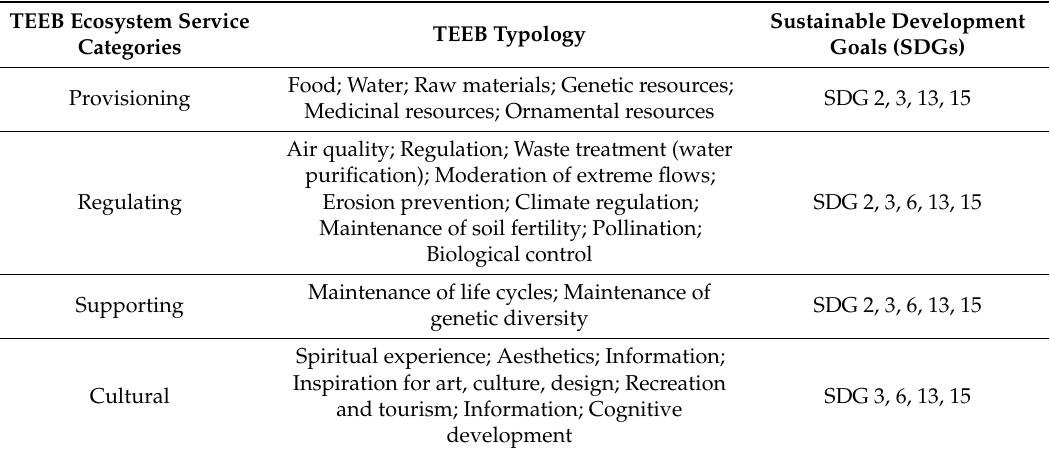
Table 1. Connection between ecosystem services and selected Sustainable Development Goals (SDGs) in relation to soil resources (adapted from